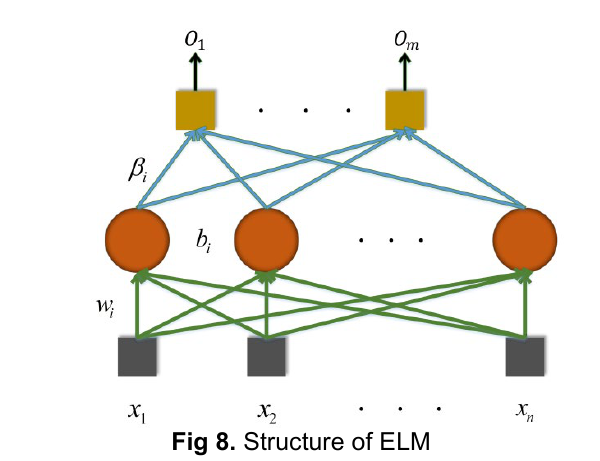
Fig 8. Structure of ELM